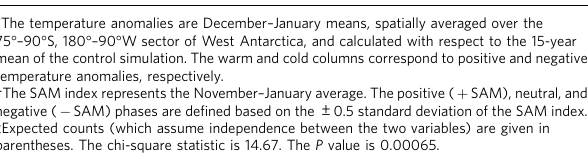
negative( (cid:2) SAM) phases are defined based on the ± 0.5 standard deviation of the SAM index. z Expected counts (which assume independence between the two variables) are given in parentheses. The chi-square statistic is 14.67. The P value is